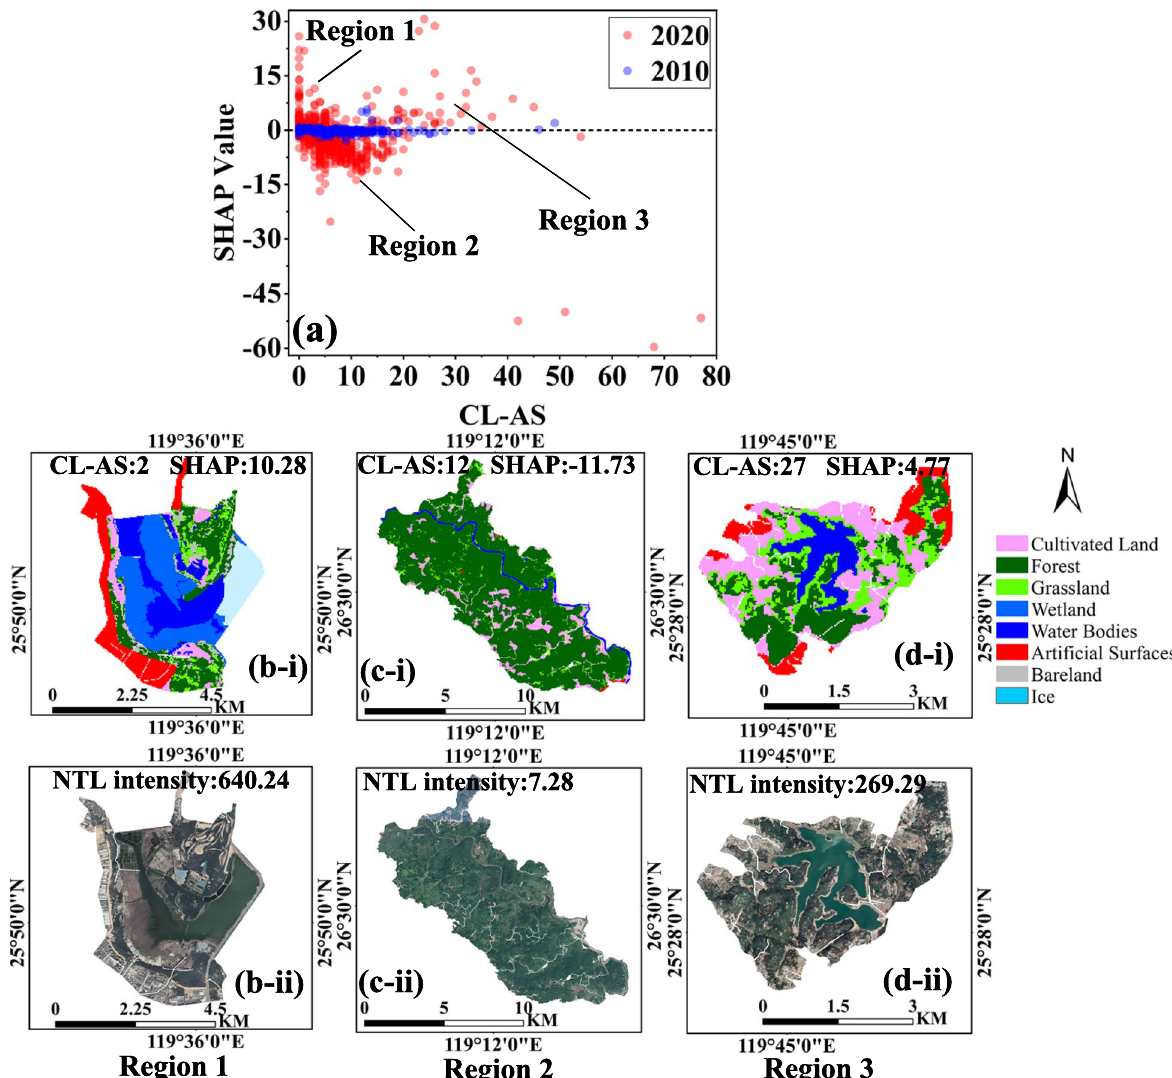
Fig. 7 Sample parcels and SHAP dependency plot of ( a ) CL-AS in 2010 and 2020 and ( b‑d ) three sample parcels’ (i) land cover maps and (ii) remote sensing